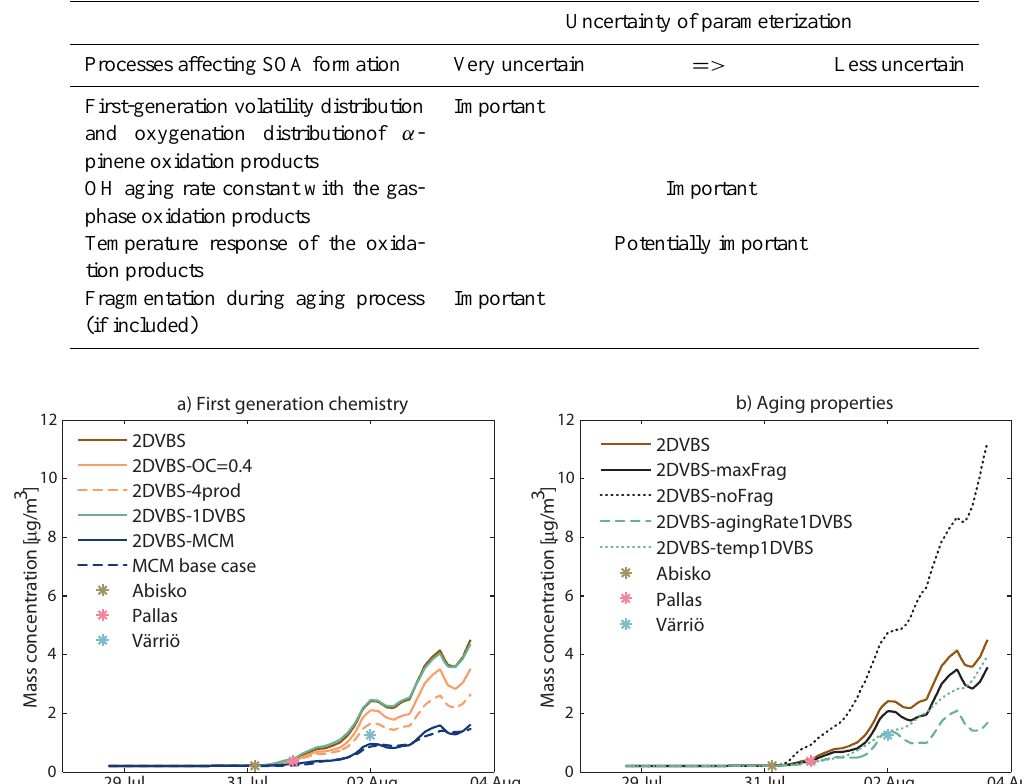
base case) already have an 89 % fragmentation probability when oxidized